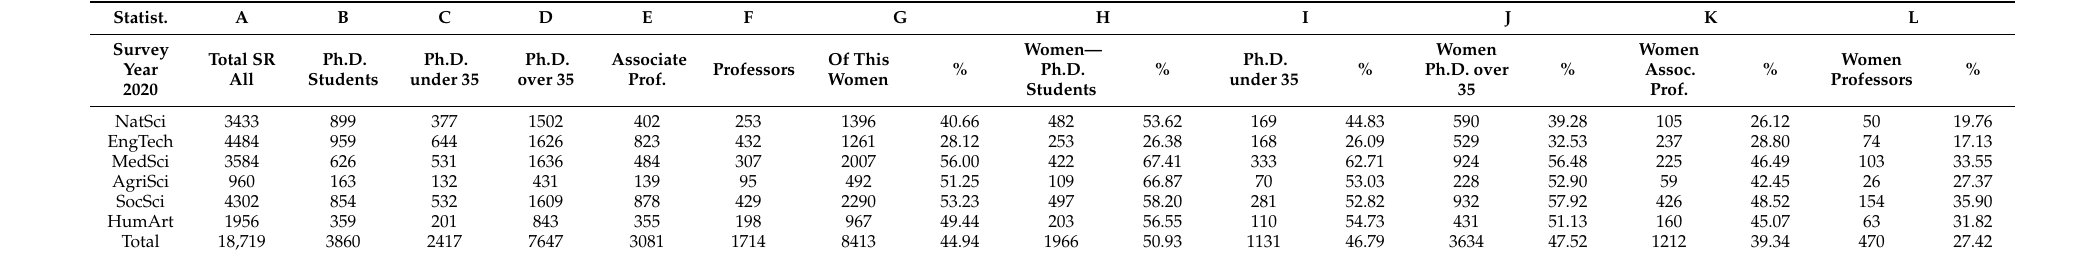
Table 6. Structure of research and development capacities by groups of science and technology fields 2020 *.